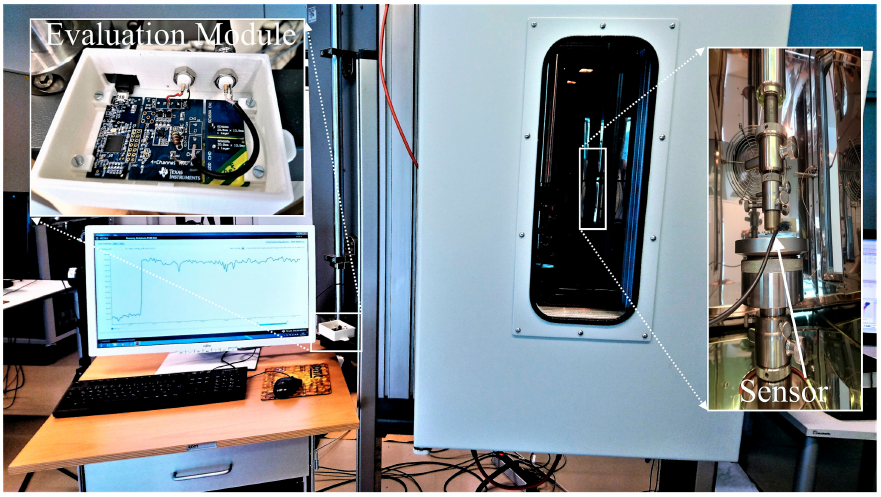
Figure 2. The test setup showing the climate chamber ( Right ) with the pressure sensor clamped in the pressure test bench and the evaluation module ( Left